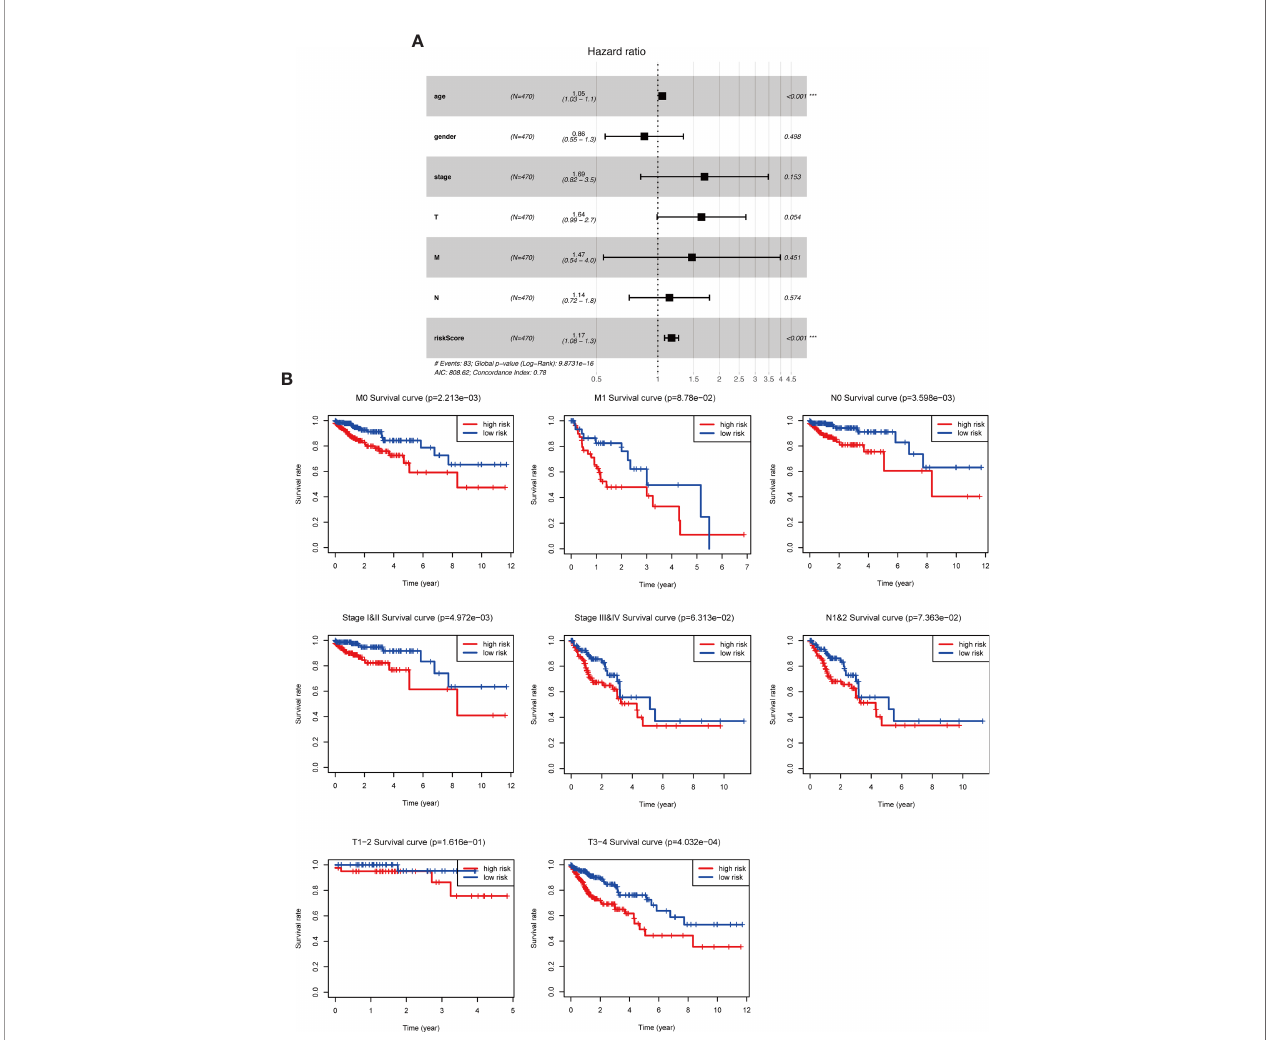
FIGURE 5 | The role of risk parameters in predicting the prognosis of patients with colorectal cancer. (A) Multifactor independent prognostic analysis. Age and risk value had a statistically signi fi cant effect on prognosis, p<0.001. (B) Survival analysis of pathological parameters based on risk values. In the survival analysis of patients at M0, M1, N0, N1&2, Stage I&II, Stage III&IV, T1-2, T3-4, the low-risk group had a more signi fi cant survival